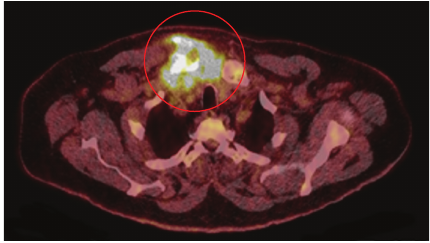
Figure 3: Patient 2. PET-CT cross-sectional view, with reaction in bone, joint, and nearby